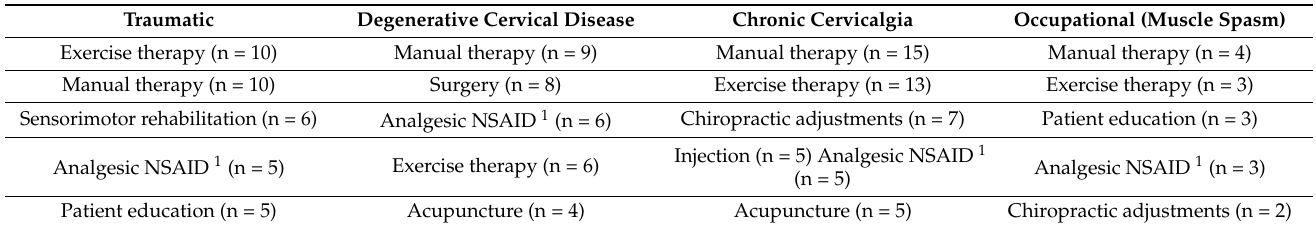
Table 4. Occurrences of interventions in articles mentioning different subpopulations of propriocep- tive cervicogenic